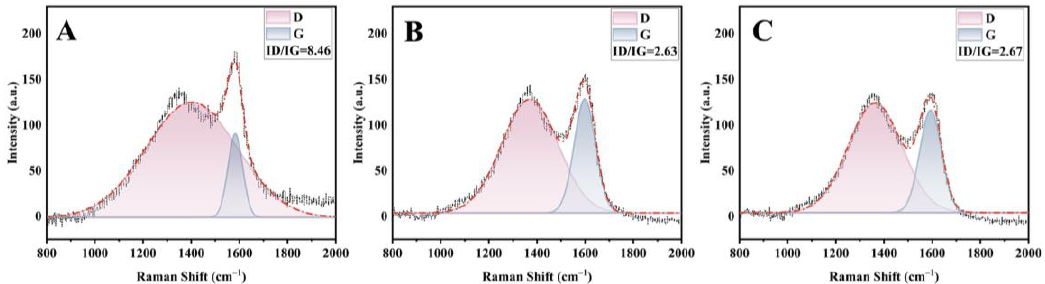
Figure 8. Raman spectra of char residues of control cotton ( A ), PAP-200 ( B ), and PAPBTCA-200 ( C ) after CCT.